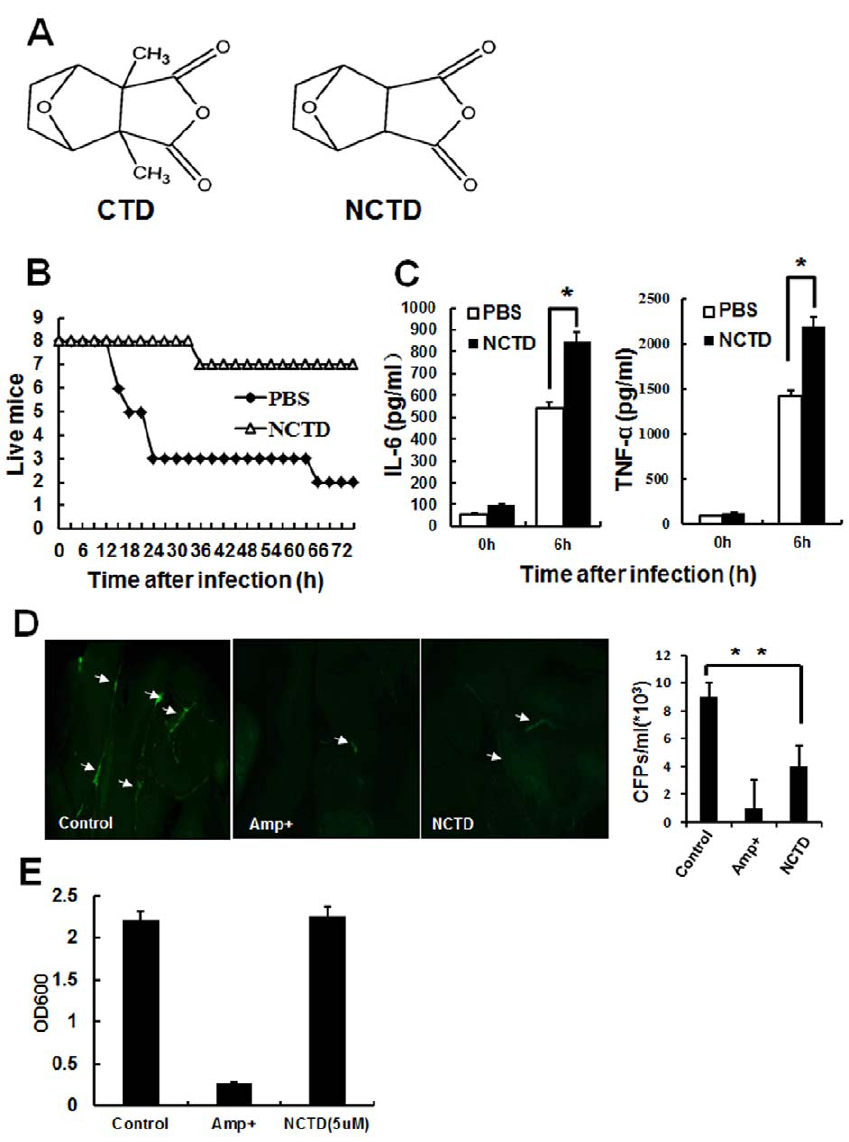
Figure 1. NCTD protects mice from bacterial-induced peritonitis. A, Chemical structure of NCTD and CTD. B, The survival of peritonitis mouse was increased by NCTD obviously. The mice were treated with NCTD or PBS at 24 h and 6 h before infection. Both NCTD and PBS (containing 0.1% DMSO) treated mice (n=8) were intraperitoneal injected with E.coli 0111 (8*10 7 ) and monitored every 3 h for 72 h. C, Serum concentration of IL-6 and TNF- a in mouse model was enhanced by NCTD. The blood was obtained 6 h after infection and the serum concentration of IL-6 and TNF- a was measured by ELISA assay. ( * , P , 0.0 5 ) Data are representative of three independent experiments with similar results. D, The quantity of bacterial was reduced in NCTD treated mouse. The mice were treated with 1 ml vehicle control (containing 0.1% DMSO), 100 ug/ml Ampicillin or NCTD (10 mg/kg) respectively followed by an i.p injection with 5 6 10 7 CFU of E. coil -GFP in 1 ml PBS for 16 h. Then the bacteria resident in abdomen was visualized by fluorescent stereomicroscope. Also, their peritoneal cavities were lavaged with 3 ml PBS, and bacterial counts were determined by plating on agar plates. n=4 mice per group. E, NCTD has no effects on the growth of E. coil -GFP. E.coli-GFP were cultured with 100 m g/ml Ampicillin (Amp + ) and 5 m M NCTD for 24 h respectively. Then the bacteria number was detected by spectrophotometer. Data are representative of three independent experiments with similar results (mean 6 s.d. in B, D). doi:10.1371/journal.pone.0044956.g001 instructions and Dnase I (RNase free) was added to avoid potential genomic DNA contamination. cDNA was then synthesized from isolated RNA by reverse transcription using the PrimeScript TM 1st Strand cDNA Synthesis kit (TAKARA). Ten percent of the synthesized cDNA was used as a template for real-time PCR using the Taq DNA polymerase (TAKARA). Primers were designed to amplify mouse cytokines, chemokines and others genes are used. For IL-6 sense: 5 9 TTC TTG GGA CTG ATG CTG 3 9 and antisense: 5 9 CTG GCT TTG TCT TTC TTG TT 3 9 ; for TNF-